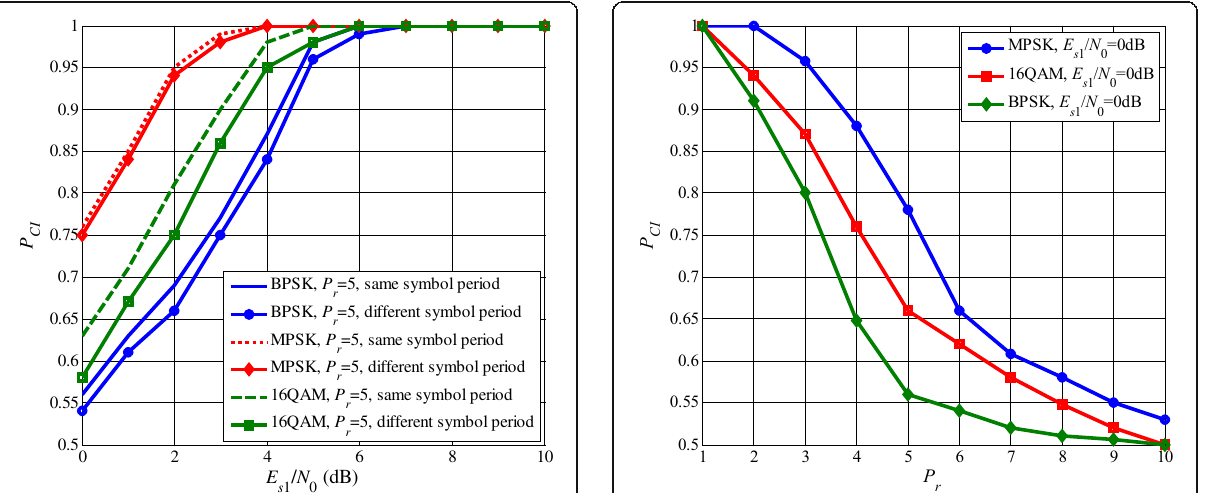
Fig. 3 The P CI as a function of the SNR for the identification of a mixed signal